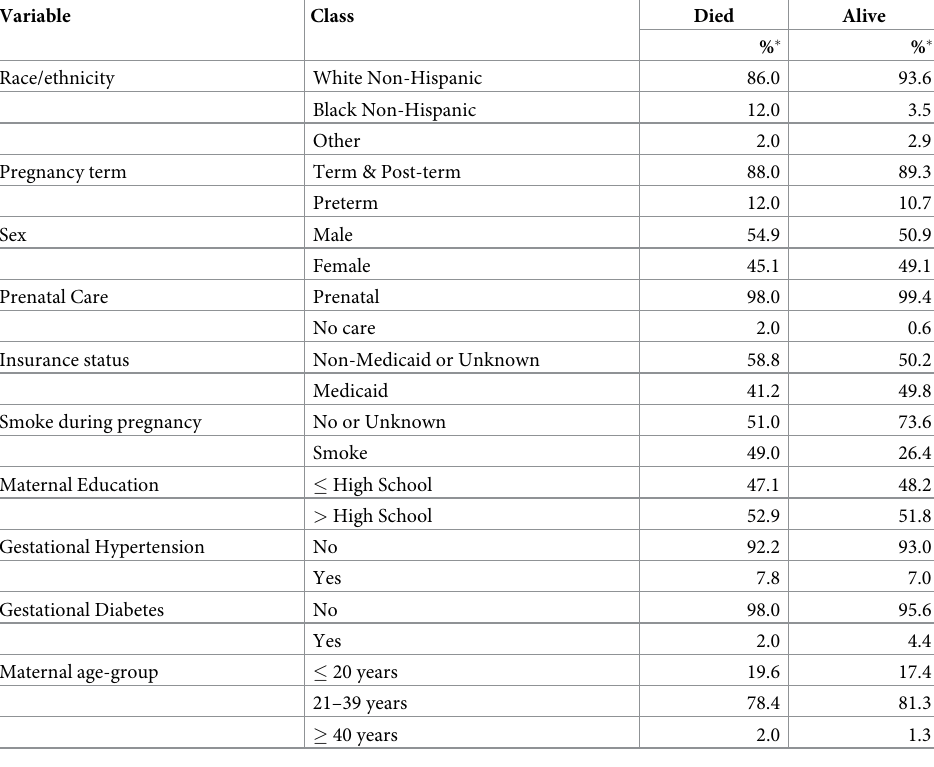
Table 1. Maternal and infant characteristics of West Virginia live births, 2010–2014, n = 102,683.